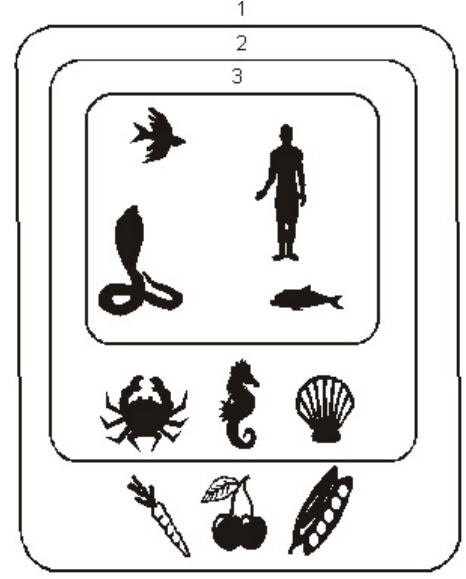
FIGURE 2. The main systems of immunogenesis: (1) constitutional, (2) phagocytic, and (3)